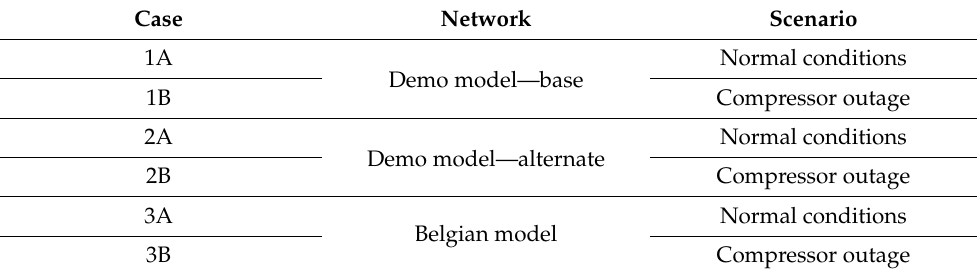
Table 1. Data for the demo networks the scenarios tested in this paper are open access and available on Github at https://github.com/NREL/SAInt_HELICS_interface (accessed on 11 April 2022). Table 1. Description of the test cases used to evaluate the co-simulation. Case Network Scenario 1A Normal conditions Demo model—base Normal conditions Demo model—alternate Belgian model